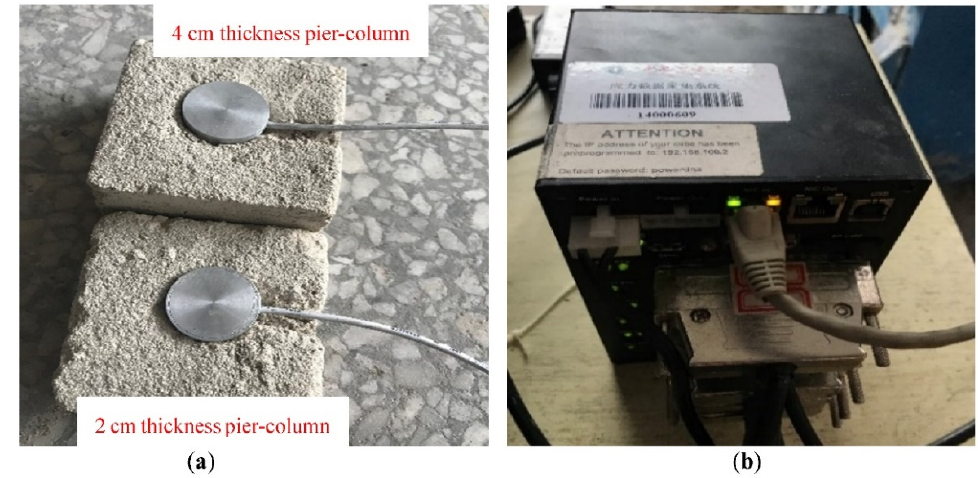
Figure 8. Physical experiments: ( a ) stress cell in different thickness backfilled pier-columns; ( b ) data logger.